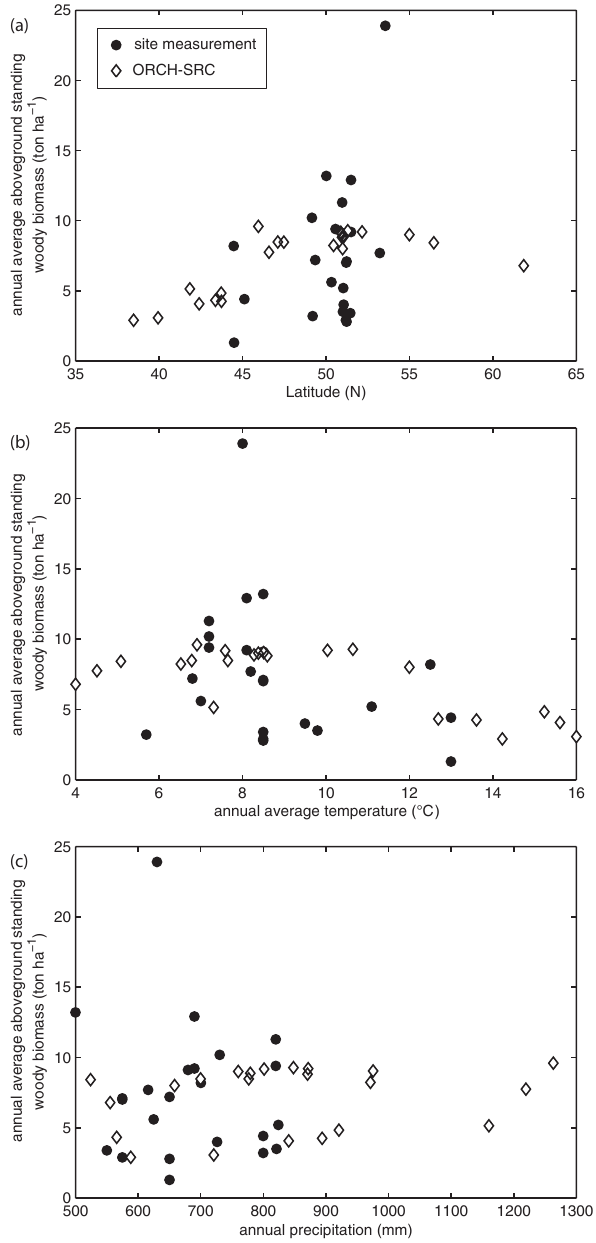
Figure 3. Comparison of aboveground standing woody biomass for ORCHIDEE-SRC simulations (open diamonds) across Europe with site measurements (black circles) across Europe. The biomass is plotted against (a) latitude, (b) annual average temperature and (c) annual precipitation.